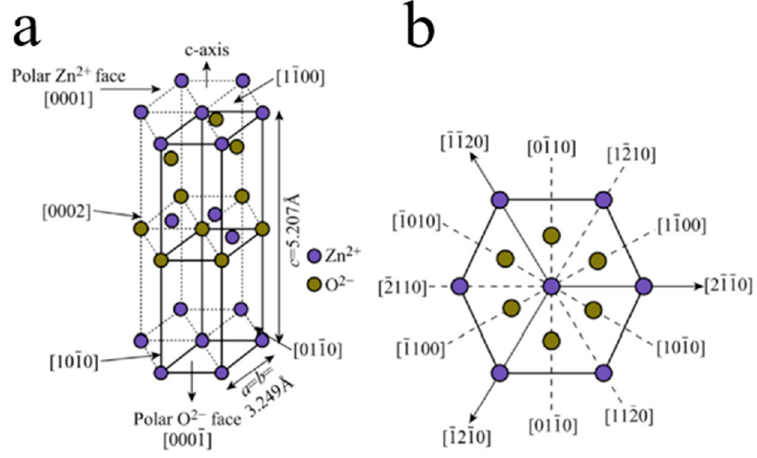
Figure 7. ( a ) ZnO unit cell with the hexagonal wurtzite structure. ( b ) Multiple crystal facets of the ZnO hexagonal wurtzite [79].